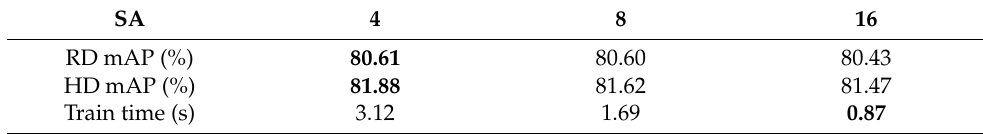
Table 3. Detection accuracy and average training time consumption of models at various